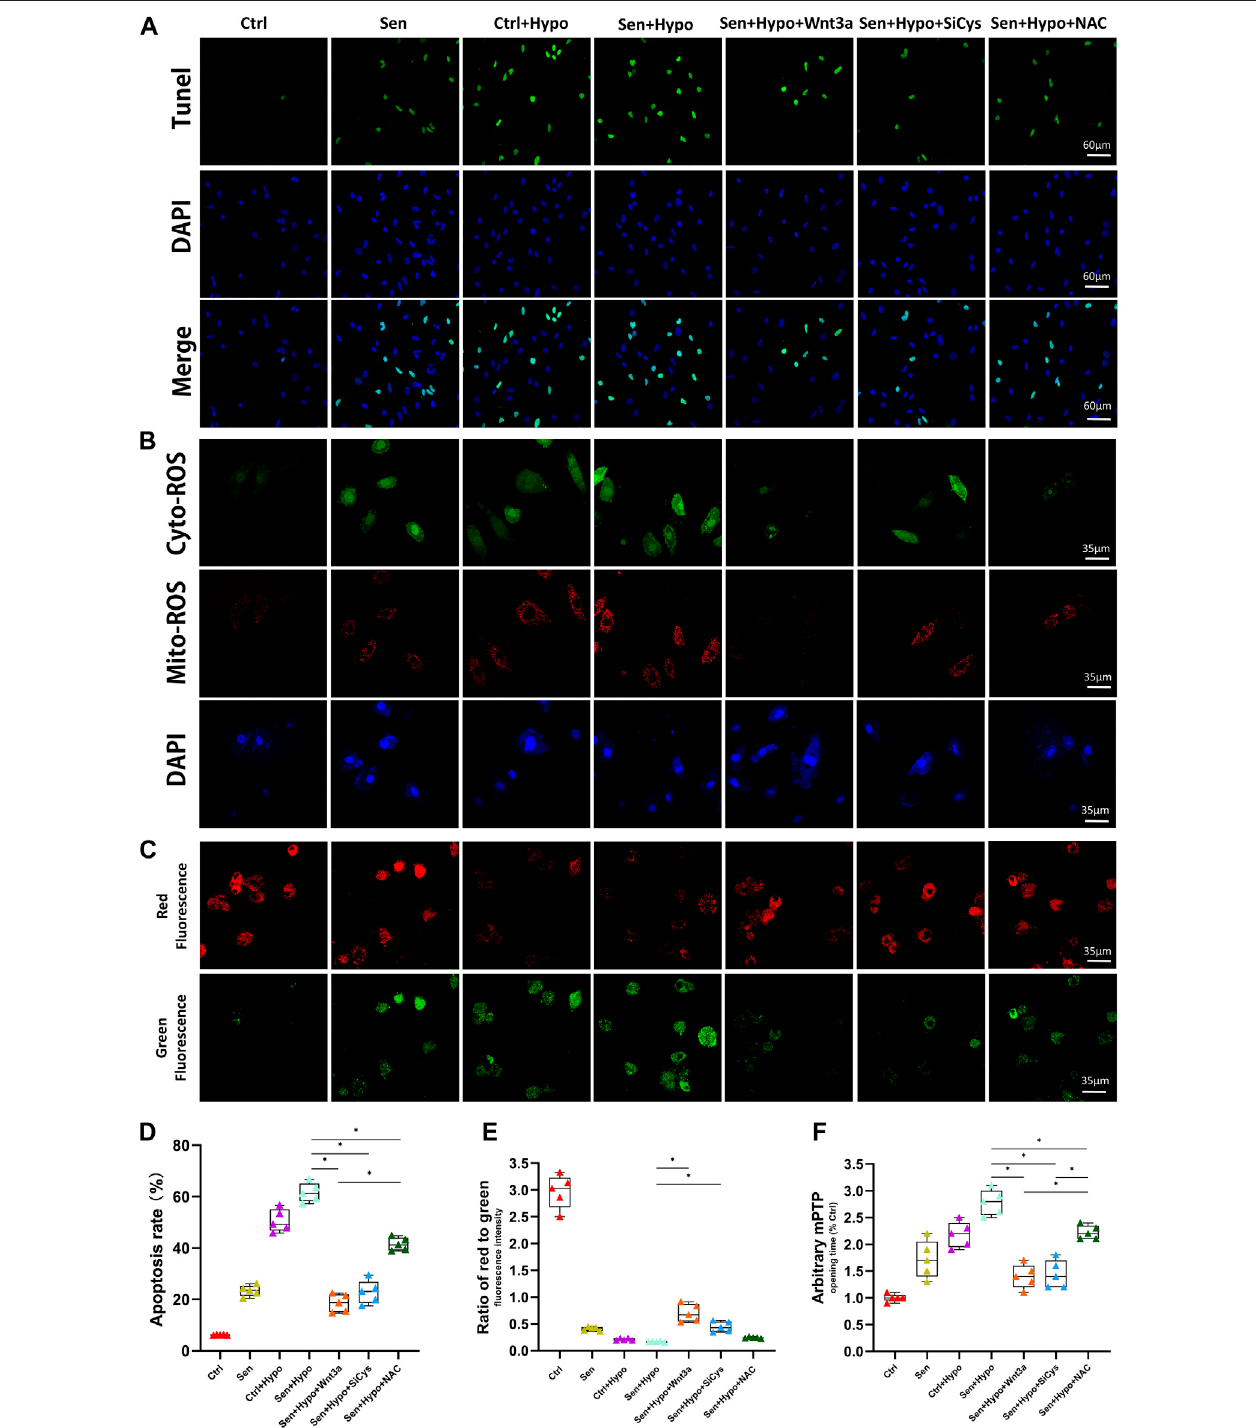
FIGURE 3 | Effects of Wnt-3a, Cys-C and NAC on senile infarcted myocardium. Representative TUNEL staining (green) and DAPI staining (blue) images (A) . The productionofROSincytosolic(green)andmitochondrial(red)indifferentgroupsbyDCFHDAandMitoSOXassaysand fl owcytometry (B) .Representativemitochondrial membranepotential( ΔΨ m)levelsimages (C) .Quantitativeanalysisofapoptotic cellsintheperipheralinfarctedareasindifferentgroups,theapoptotic rateofexogenous treatmentofWnt3aorNACand knockeddown Cys-C allshowedasigni fi cantdecrease compared withtheSen+Hypo group( p < 0.05) (D) .Quantitative analysis ofmitochondrialmembranepotential( ΔΨ m)levelsquantitativeanalysis (E) andmitochondrialpermeabilitytransitionpore(mPTP)openingtimequantitativeanalysis (F) in differentgroups,theSen+Hypo groupsigni fi cantlyaccountedforprolongedmPTPopeningtime anddecreased ΔΨ m(ratio ofredtogreen),whileWnt3a,siCys-C,and